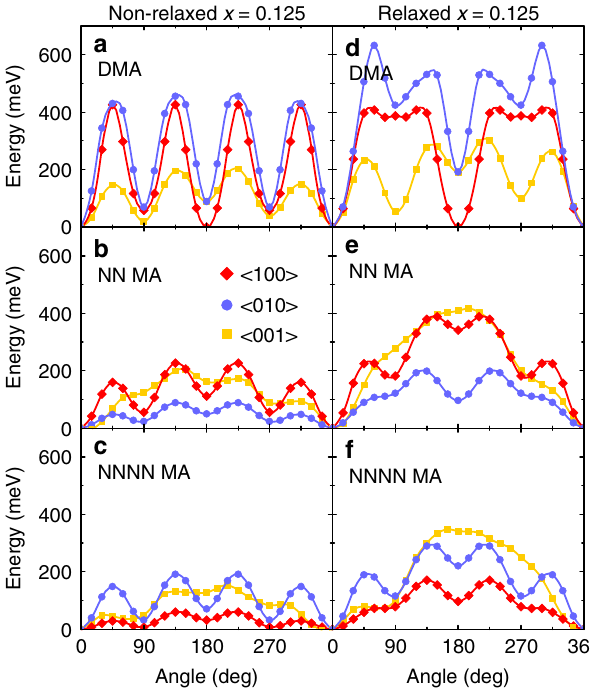
Fig. 5 The potential energy surfaces obtained by rotating DMA and neighboring MA cations within a MA 0.875 DMA 0.125 PbBr 3 system. Rotations of a , d DMA and b , c , e , f MA cations are performed in a – c nonrelaxed and d – f relaxed structures of MA 0.875 DMA 0.125 PbBr 3 system. The cations are rotated around the <100> (red), <010> (blue) and <001> (yellow) axes. The rotation axes cross the cation center of mass. The curves are guides for